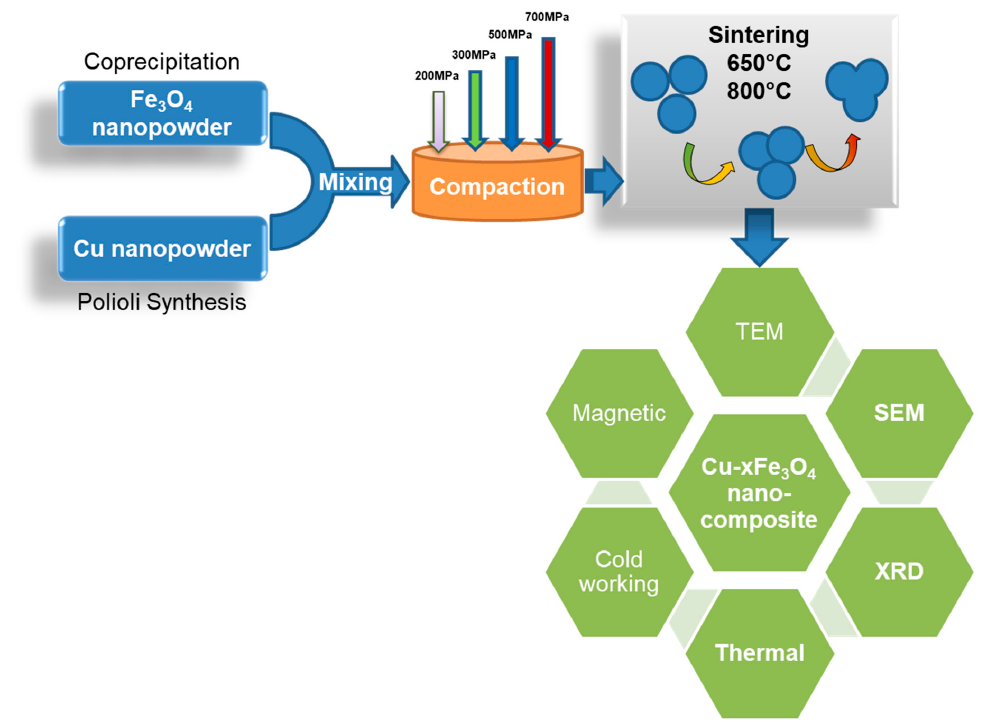
Figure 1. Illustration of the process diagram for synthesis and characterization of Cu-xFe 3 O 4 nanocomposites.